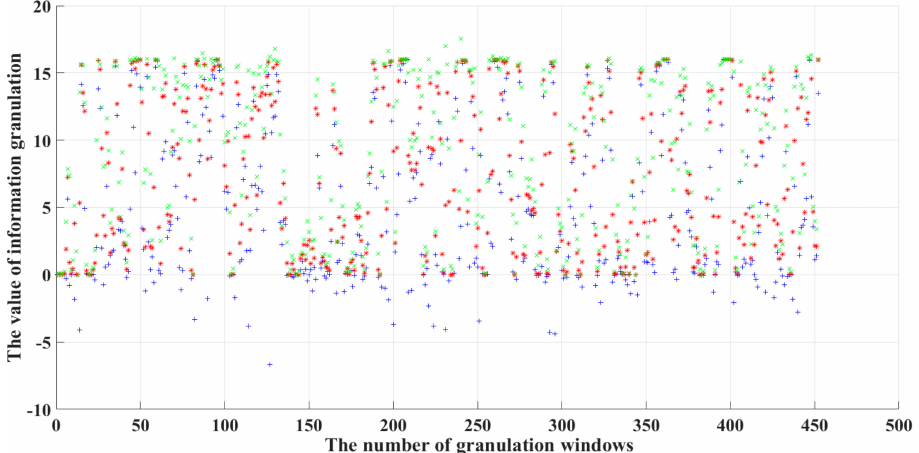
Figure 7. The output value of wind energy after information granulation.